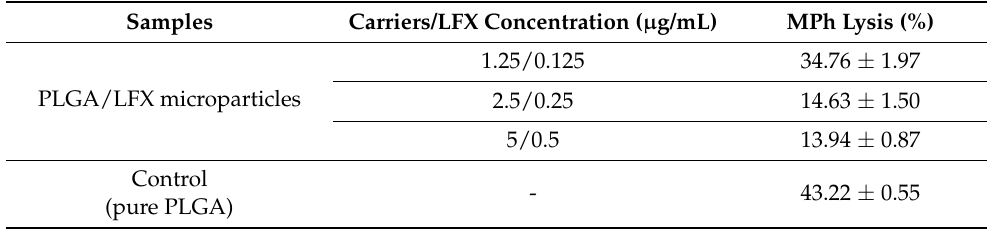
Table 3. Lysis of the infected MPhs incubated in the presence of the microparticles tested.